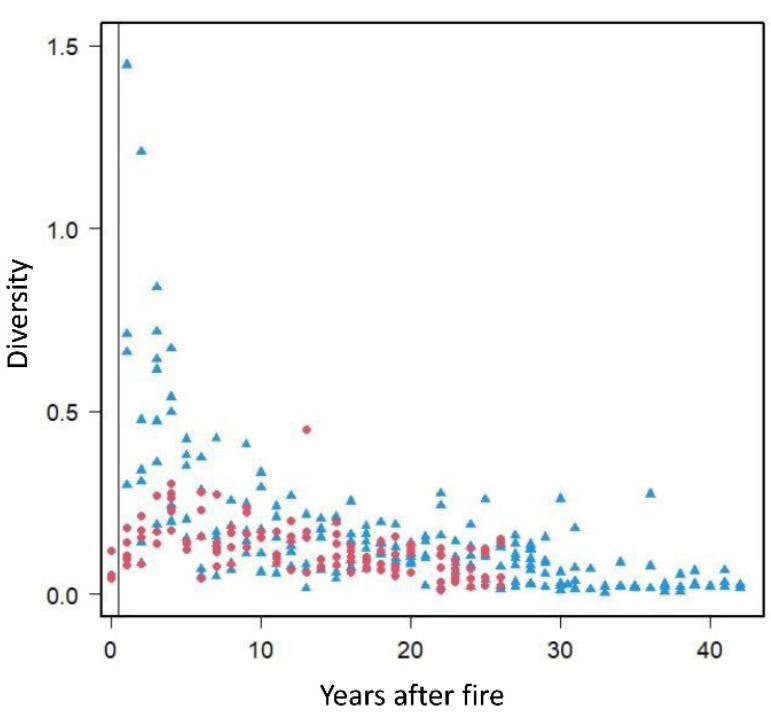
Figure 6. Alpha diversity (conditional within-sample variance on the first CA axis) as a function of time since burn in holm oak samples (blue triangles) and in cork oak samples (red dots).